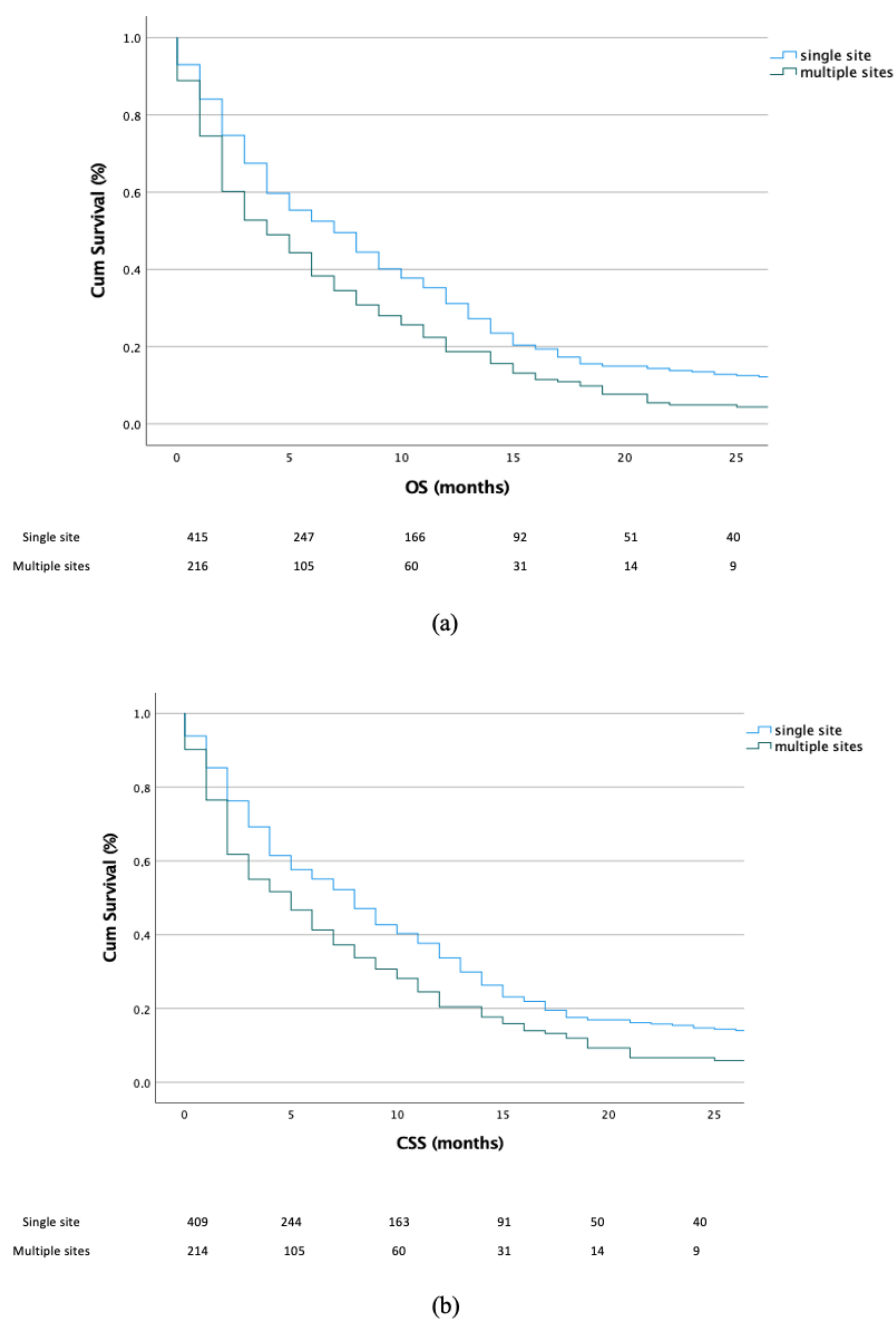
Figure 1. Kaplan–Meier plots depicting the OS ( a ) and CSS ( b ) according to single vs. multiple metastatic organ(s) patients.